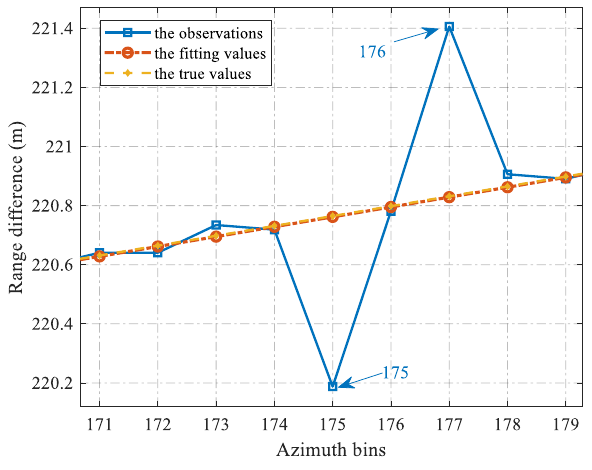
Figure 6. Observations with large errors, and comparisons with corresponding fitting values and true